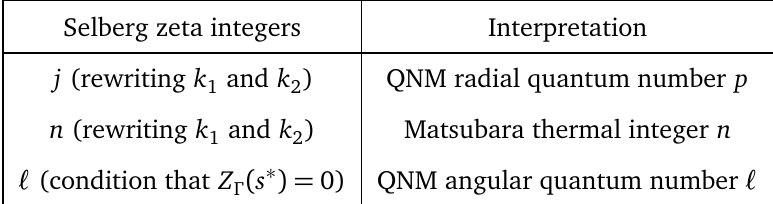
Table 1: The dictionary associating the repackaging of Selberg zeta function integers and their interpretation in terms of quasinormal modes and Matsubara frequencies.